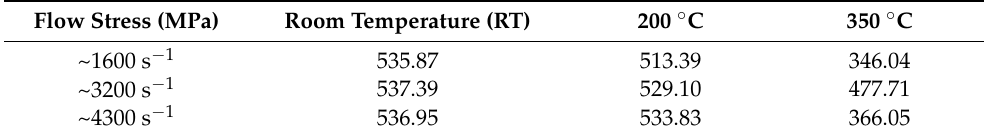
Table 1. The flow stress at 15% applied strain for each loading